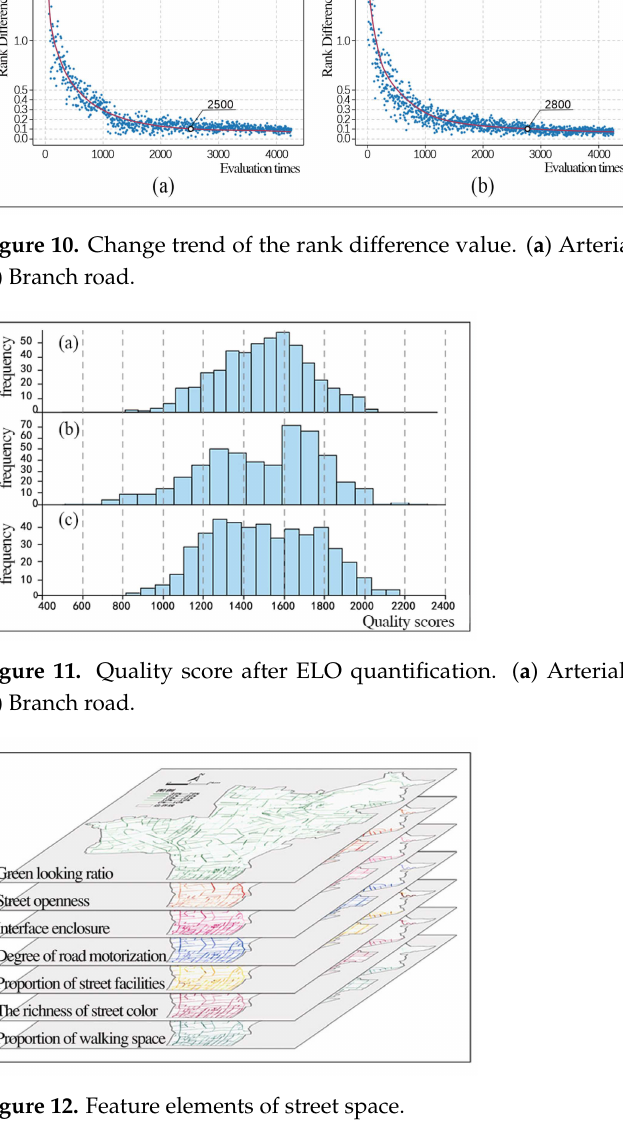
Figure 12. Feature elements of street